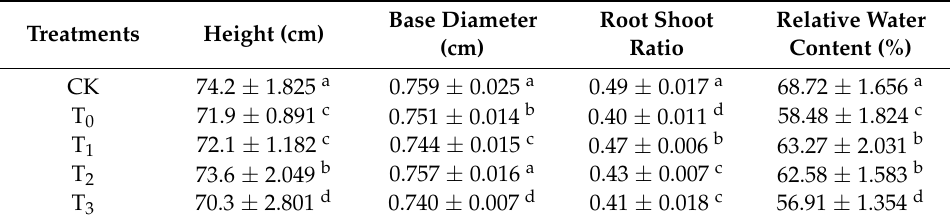
Table 1. Effect of the NO (nitric oxide) donor on the height of Larix gmelinii seedlings under enhanced UV-B (Ultraviolet-B)